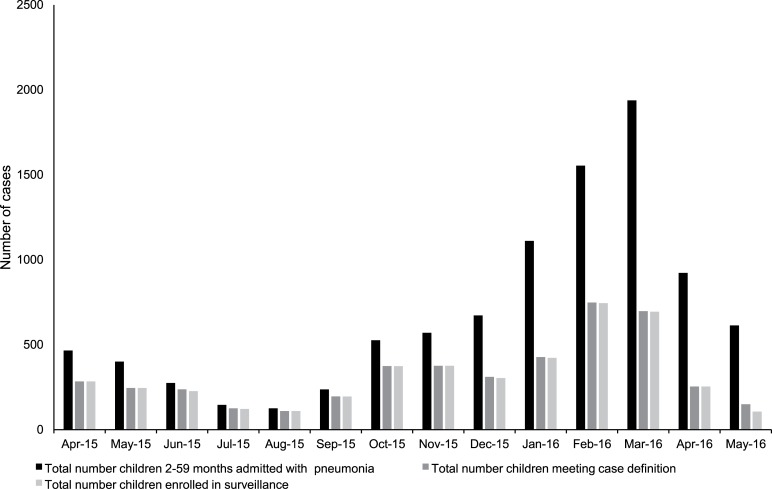
Total pneumonia admissions and children 2–59 months screened and enrolled into the surveillance program, Mongolia, April 2015-May 2016.*Numbers of children meeting the case definition were not available for April and May 2015, so they were assumed to be equal to enrolments numbers based on experience from other months.